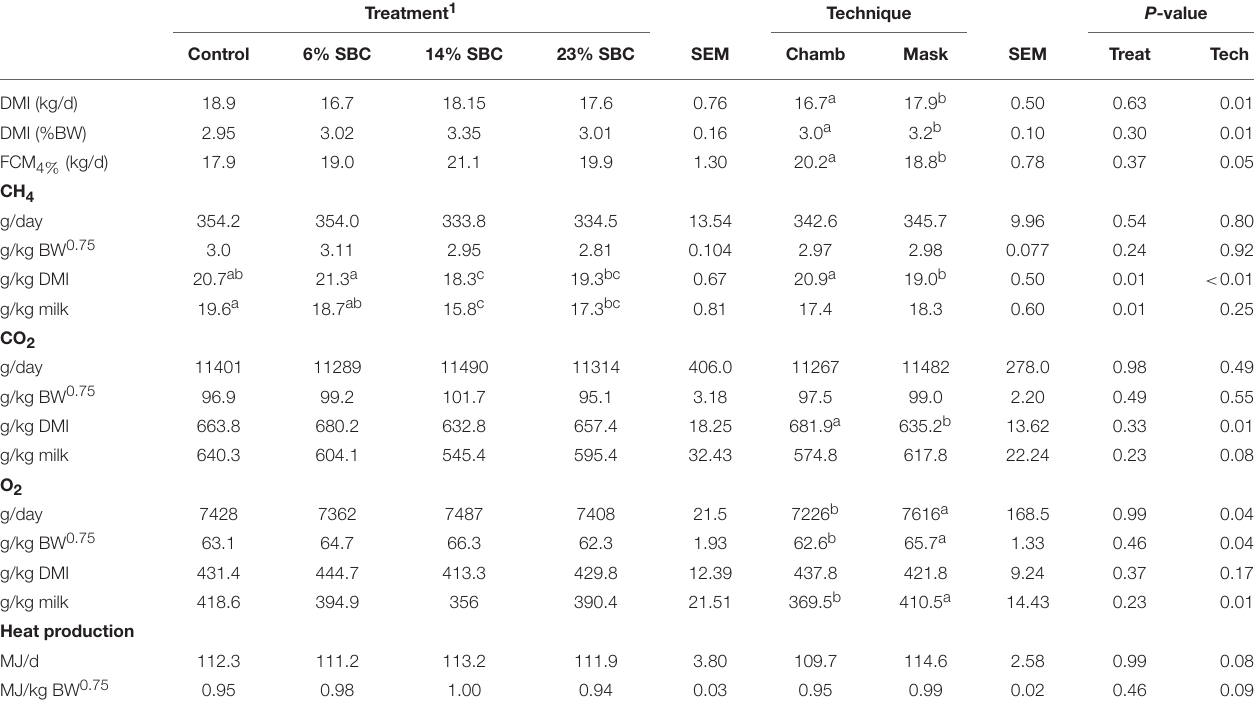
TABLE 6 | Effect of replacing soybean meal (SBM) with soybean cake (SBC) on enteric CH 4 and CO 2 outputs, O 2 consumption and heat production in dairy cows. Treatment 1 Technique